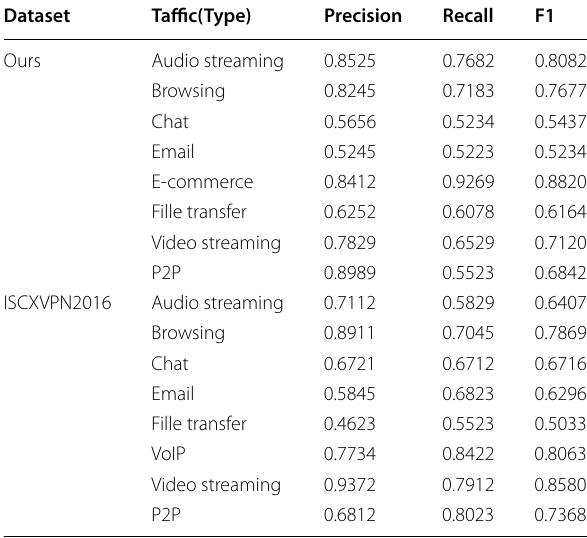
Table 4 The results of SCGAE for each application